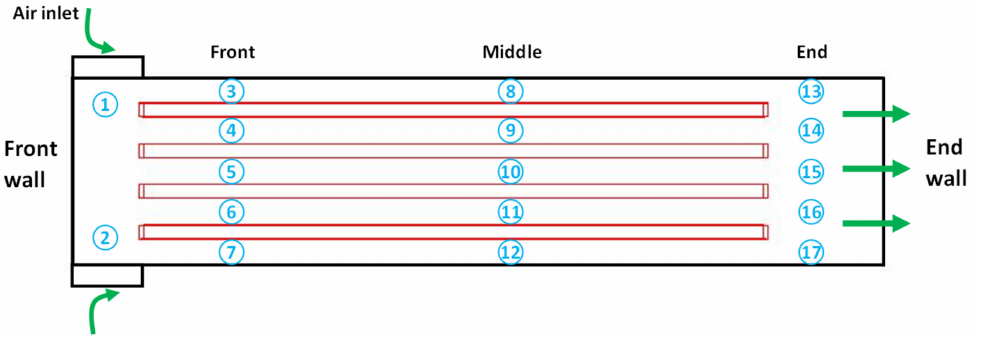
Figure 8. Schematic drawing of the locations of the sensors inside the analyzed poultry house. No. 1~No. 17 indicate the locations of the sensors. Table 6. Environmental parameters monitored during the validation test.